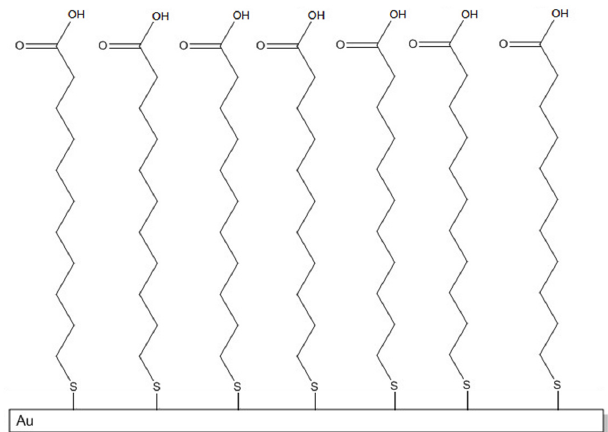
Figure 3. Schematic representation of SAM (Self Assembled Monolayer) with free –COOH and covalent bonds Au-S.